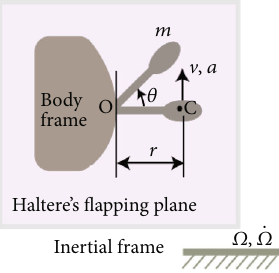
Figure 6: Cross-section of the thorax along the haltere ’ s fl apping